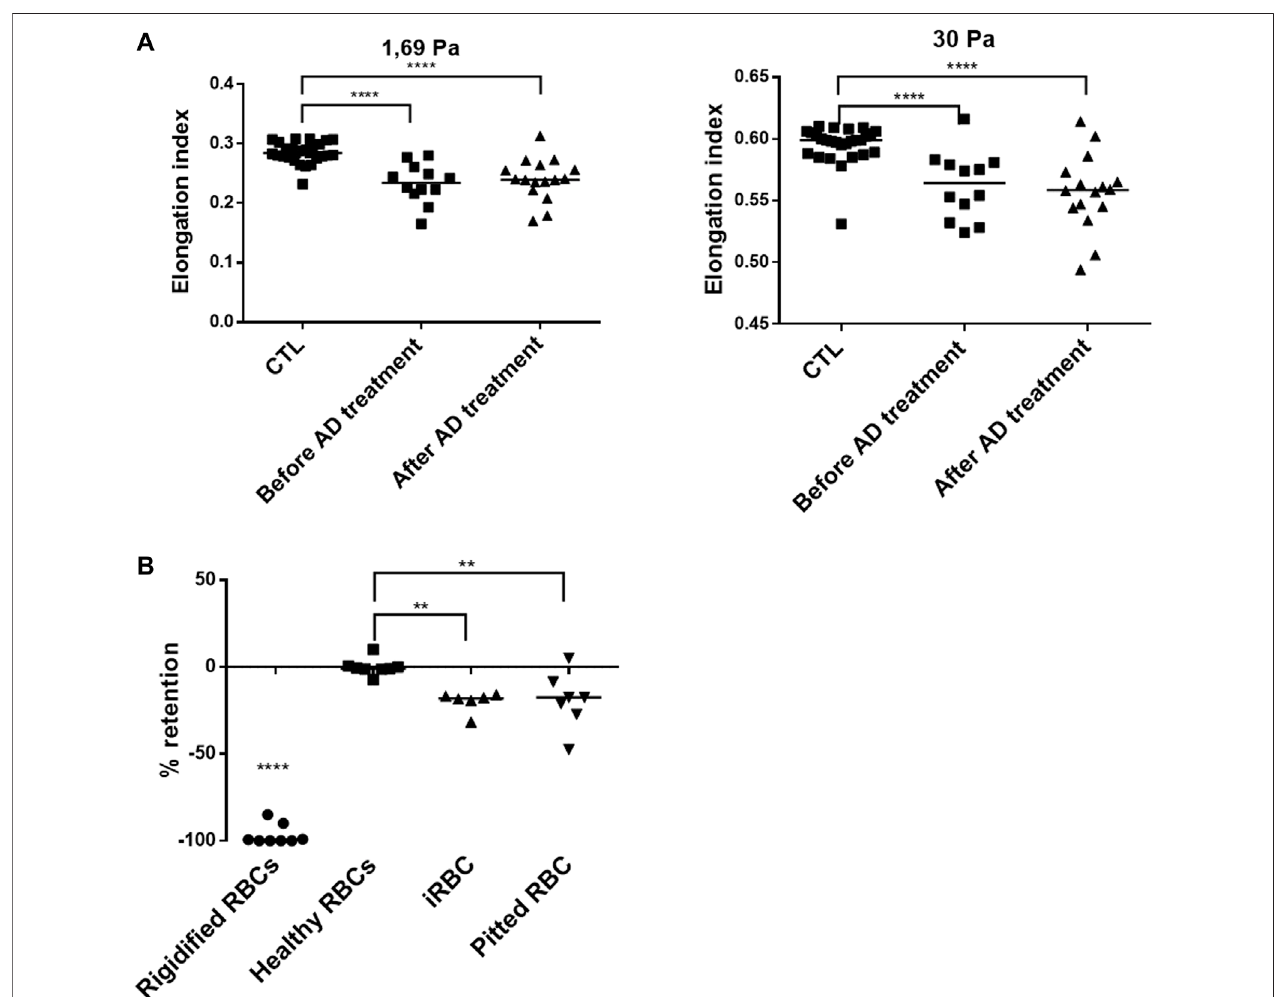
FIGURE 3| Altered functional properties of circulating RBCs. (A) . Elongation index at different shear stresses of RBC from patientsbefore antimalarial therapy ( n = 12)oruponfollow-up( n =16),comparedtoRBCsfromhealthydonors(CTL, n =27). (B) .Retentionofglutaraldehyde- fi xedRBC(Rigidi fi edRBC, n =8),healthyRBC( n = 8), patient iRBC ( n = 6), and pitted RBC ( n = 7). Negative values re fl ect retention in microspheres; positive values re fl ect